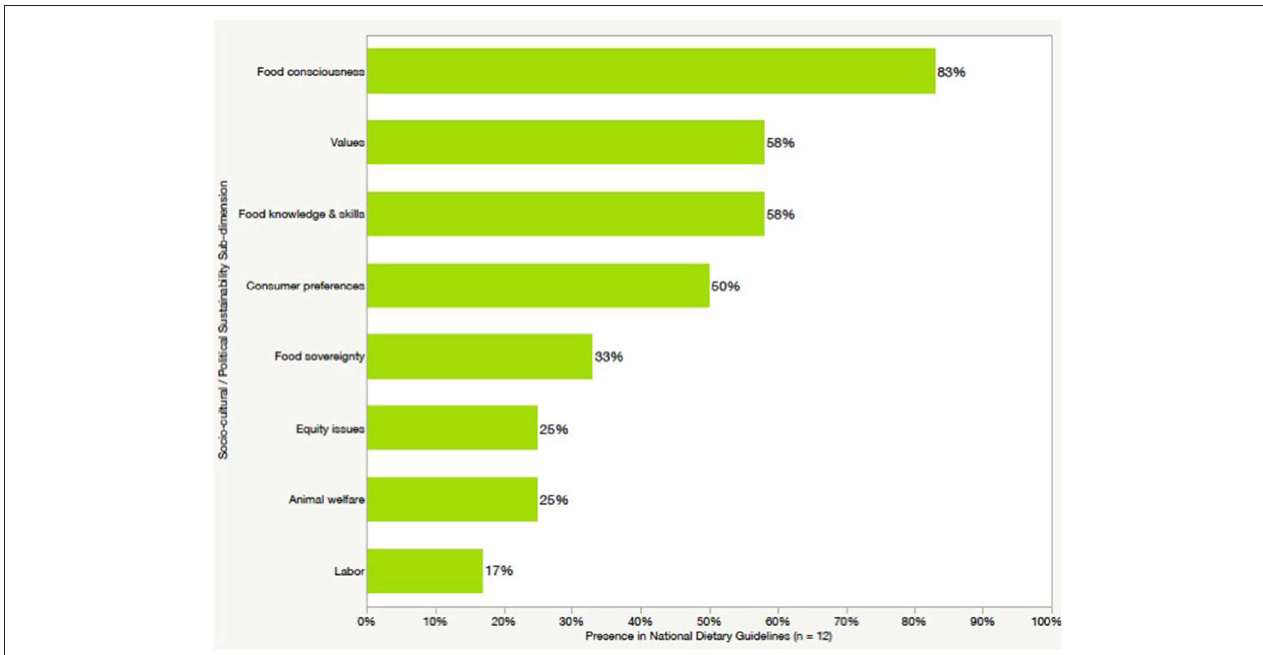
FIGURE 5 | Presence of socio-cultural and political sub-dimensions in national dietary guidelines. This figure demonstrates the presence of the eight sub-dimensions of socio-cultural and political sustainability in the 12 national dietary guidelines evaluated in this